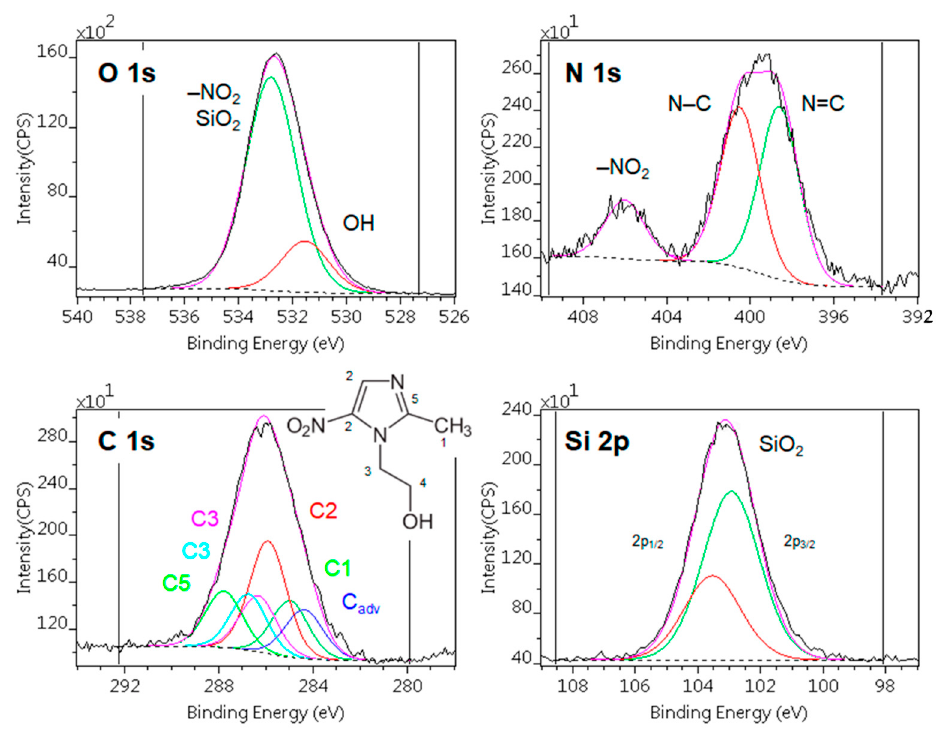
Figure 2. Typical X-ray photoelectron spectra of the metronidazole adsorbed on silica (sample SyM2 ). Photoelectron lines are decomposed to various chemical states.